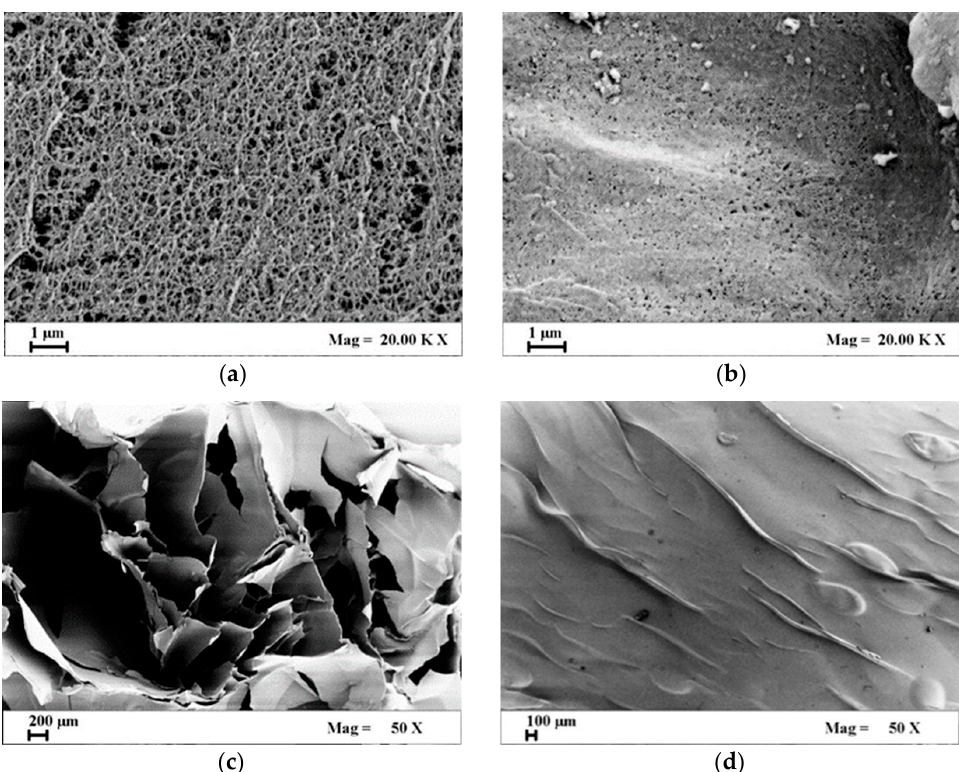
Figure 2. FE-SEM images of 3% w/w agarose aerogel: ( a ) section and ( b ) surface. Images of 3% w/w cryogel: ( c ) section and ( d ) surface.